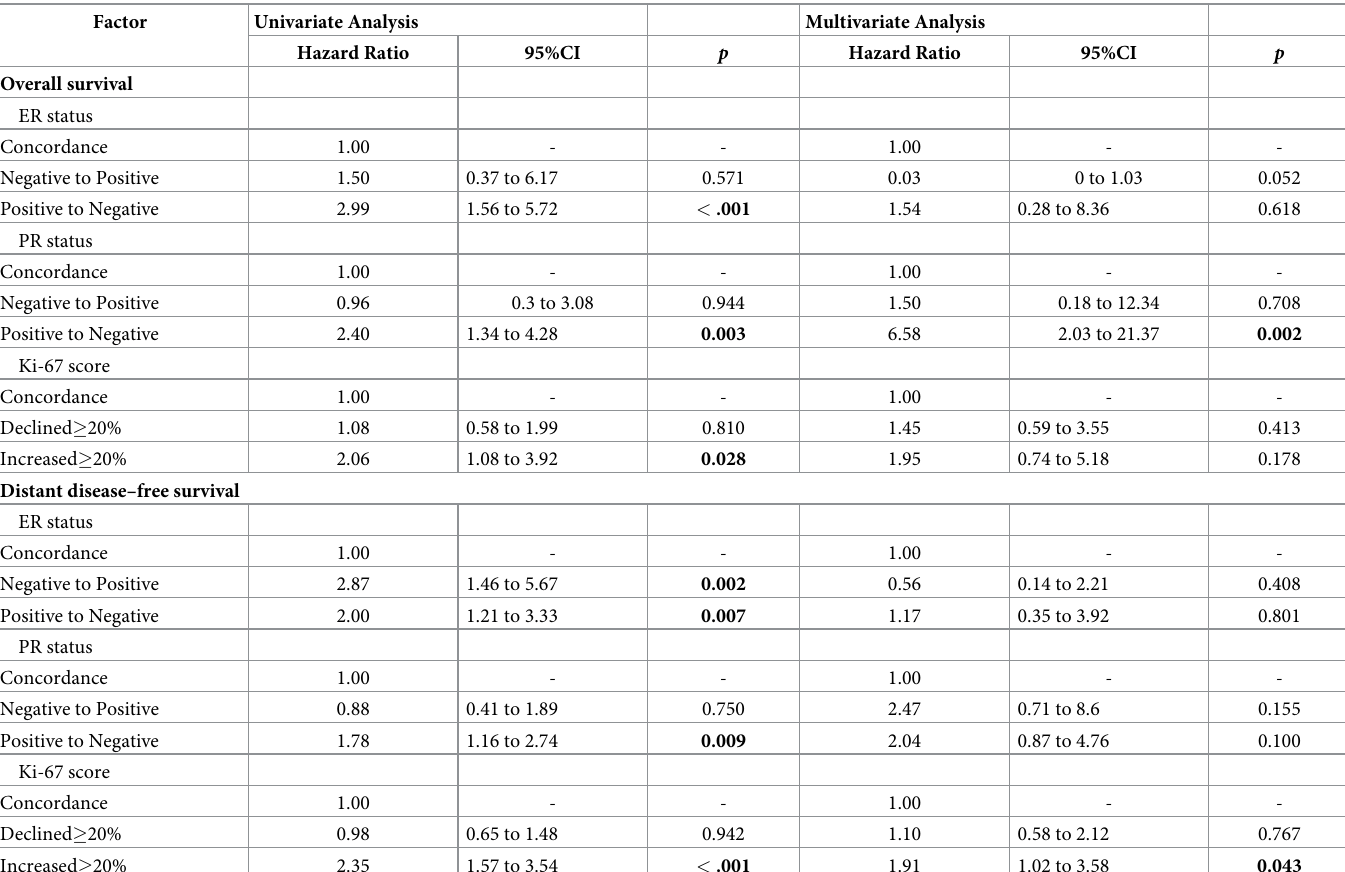
Table 2. Predictors of